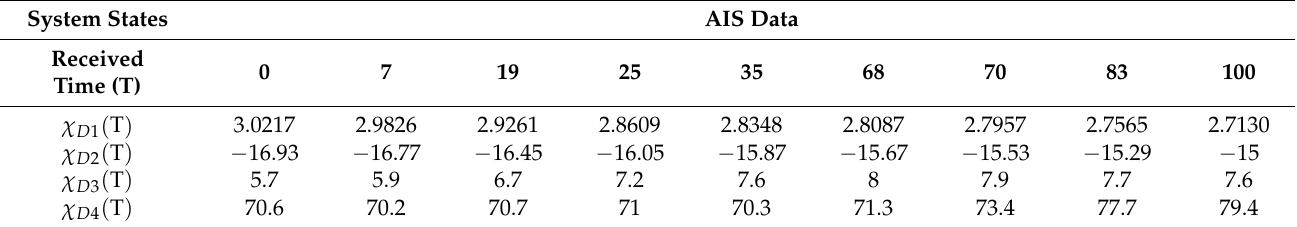
Table 1. Objective AIS